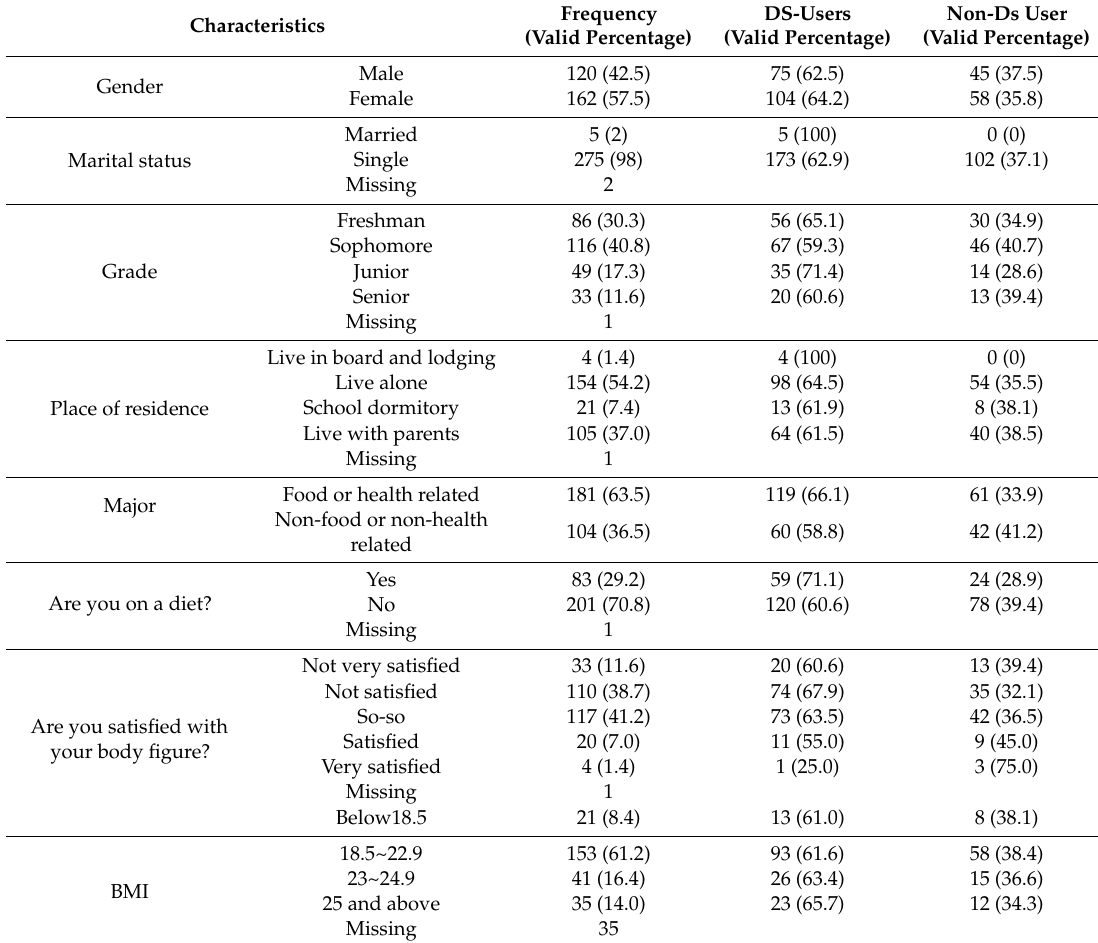
Table 1. Characteristics of Demographics of the Respondents ( n =